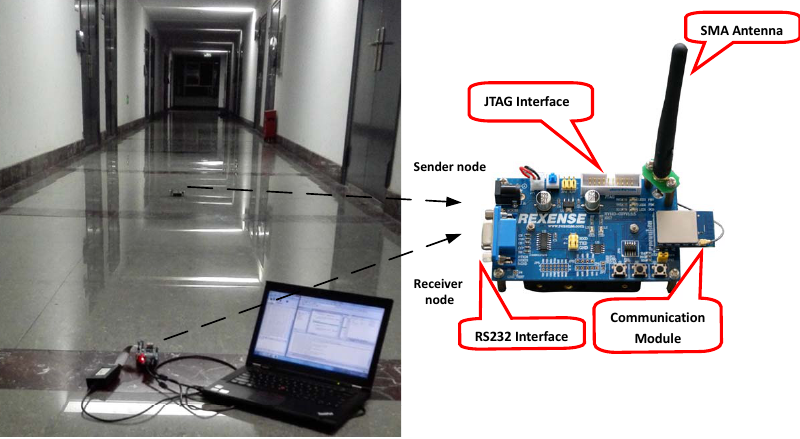
Figure 21. Spatial characteristic of the wireless